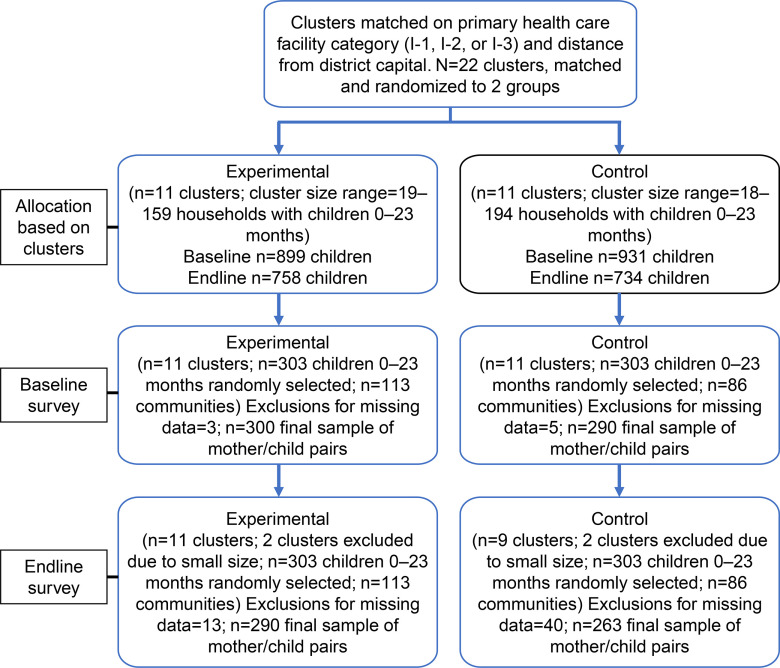
Allocation of Clusters and Study Population, Huánuco Region, Peru